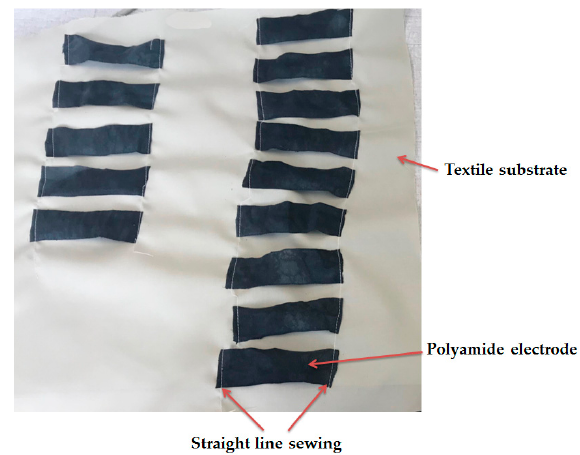
Figure 4. Polyamide textile electrodes sewn onto textile substrate before washing.